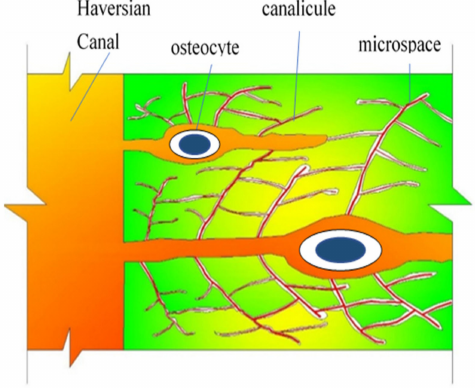
Figure 4. A schematic diagram of a bone